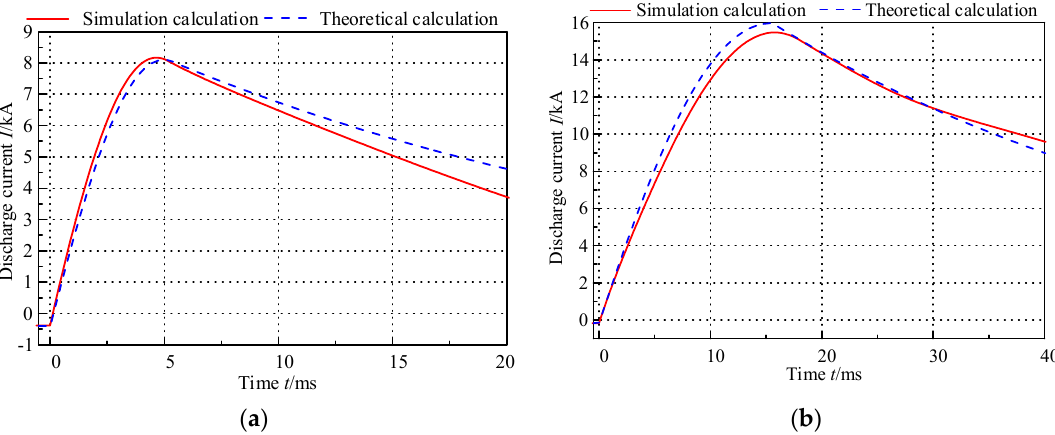
Figure 14. The current waveform under F2 fault by theoretical calculation and simulation calculation: ( a ) VSC1 discharge current when F2 fault occurs in DCSST1 and ( b ) DCSST1 discharge current when F2 fault occurs in VSC1.